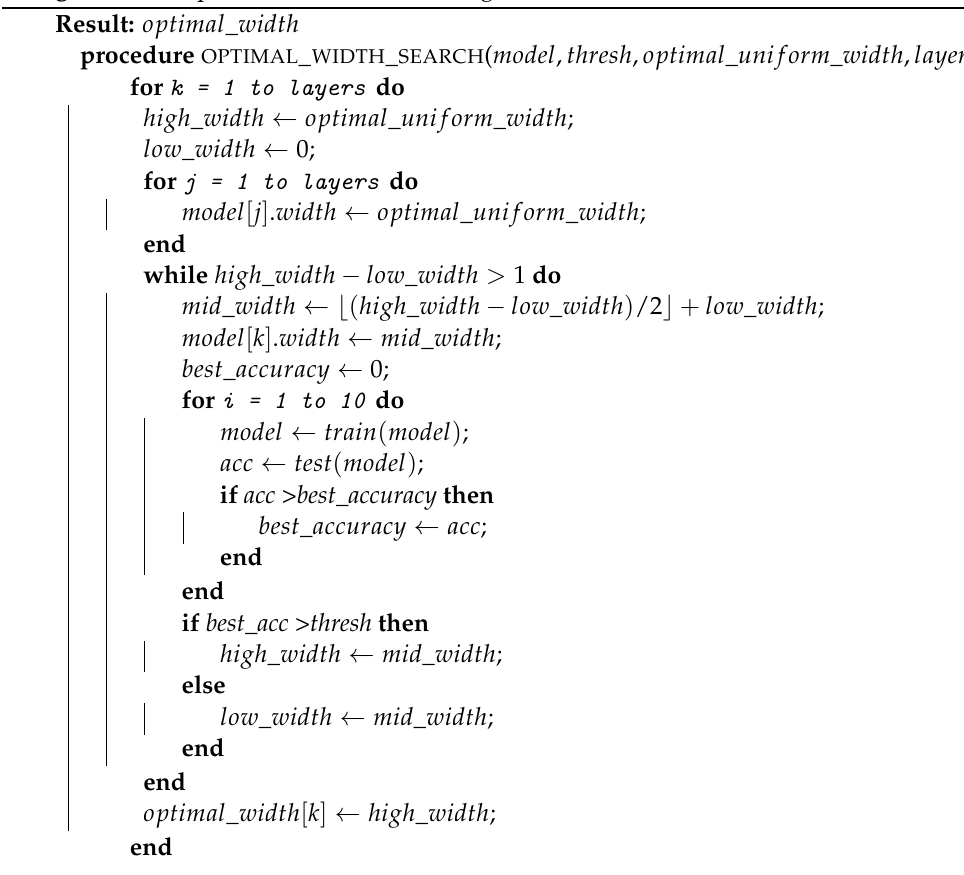
Algorithm 2: Optimal width search for a given BNN